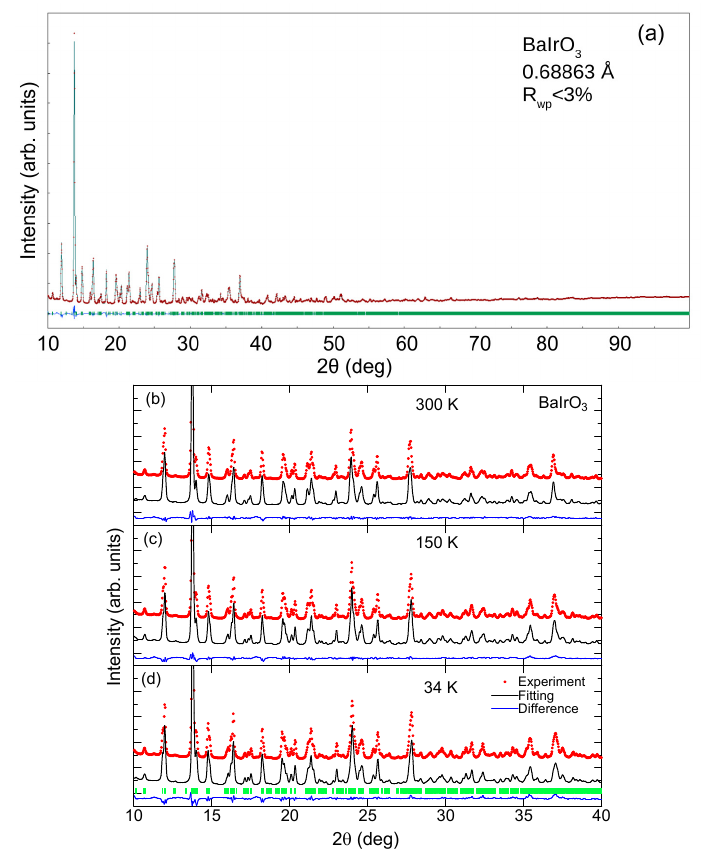
Figure 2. ( a ) synchrotron X-ray diffraction pattern of BaIrO 3 at room temperature. For the details of the refinement, see text. Comparison between the observed data and the refinement at ( b ) 300 K; ( c ) 150 K; and ( d ) 34